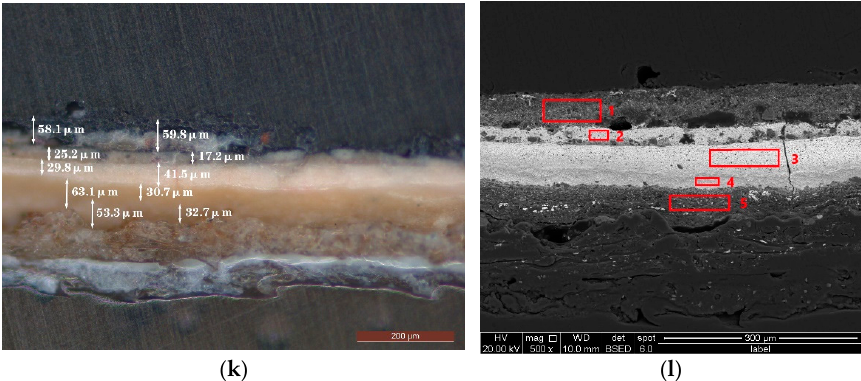
Figure 5. OM and BSE images of the sample cross-sections revealing paint stratigraphy. ( a ) OM images of 1-1 blue sample; ( b ) BSE images of 1-1 blue sample; ( c ) OM images of 1-2 yellow sample; ( d ) BSE images of 1-2 yellow sample; ( e ) OM images of 1-3 red sample; ( f ) BSE images of 1-3 red sample; ( g ) OM images of 1-4 green sample; ( h ) BSE images of 1-4 green sample; ( i ) OM images of